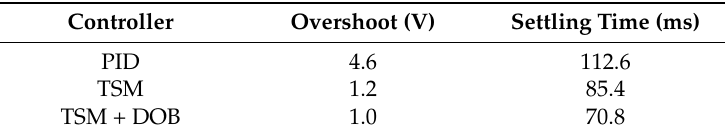
Table 4. Comparisons under PID, TSM, and TSM + DOB when the step-input-voltage